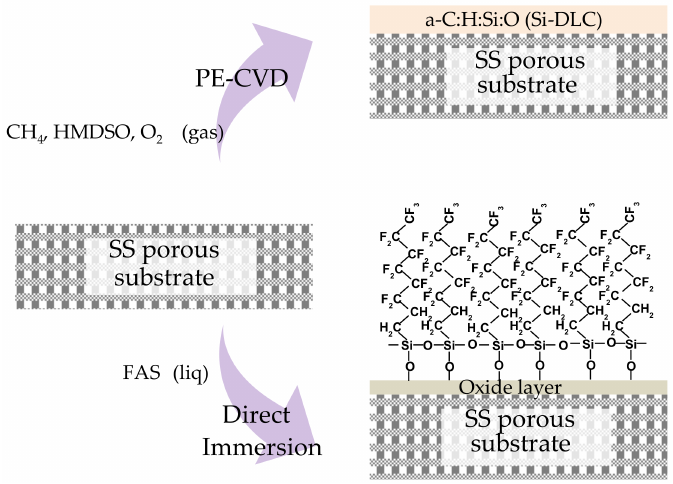
Figure 2. Schematic overview of the processes applied in this study.